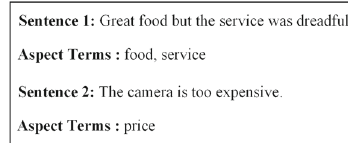
captured by these neural network-based sequence labeling methods in the ATE task. Besides, they have a weak capacity in modeling dependencies between